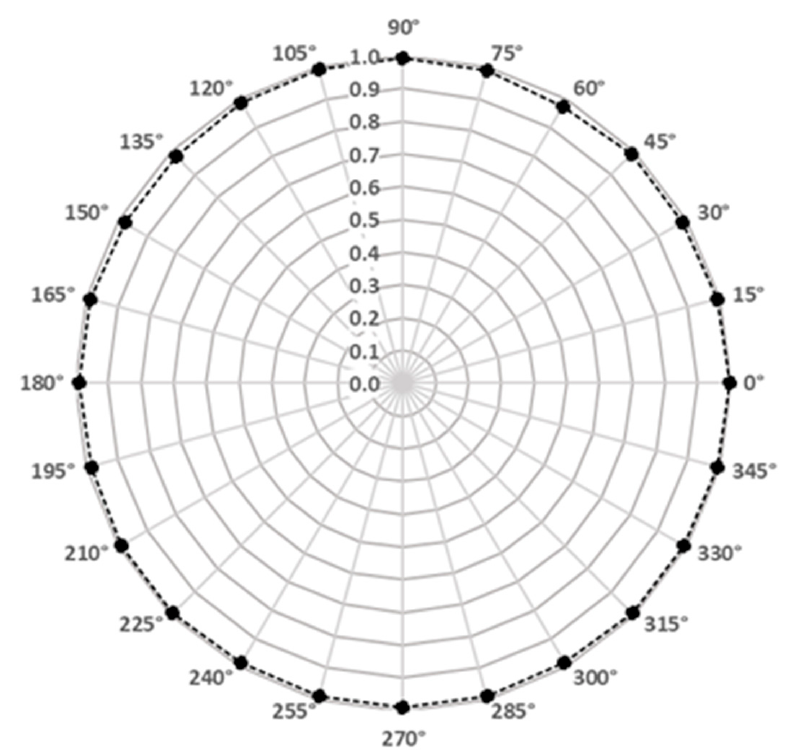
Figure 6. Relationship between tracking direction and R² of the regression line.